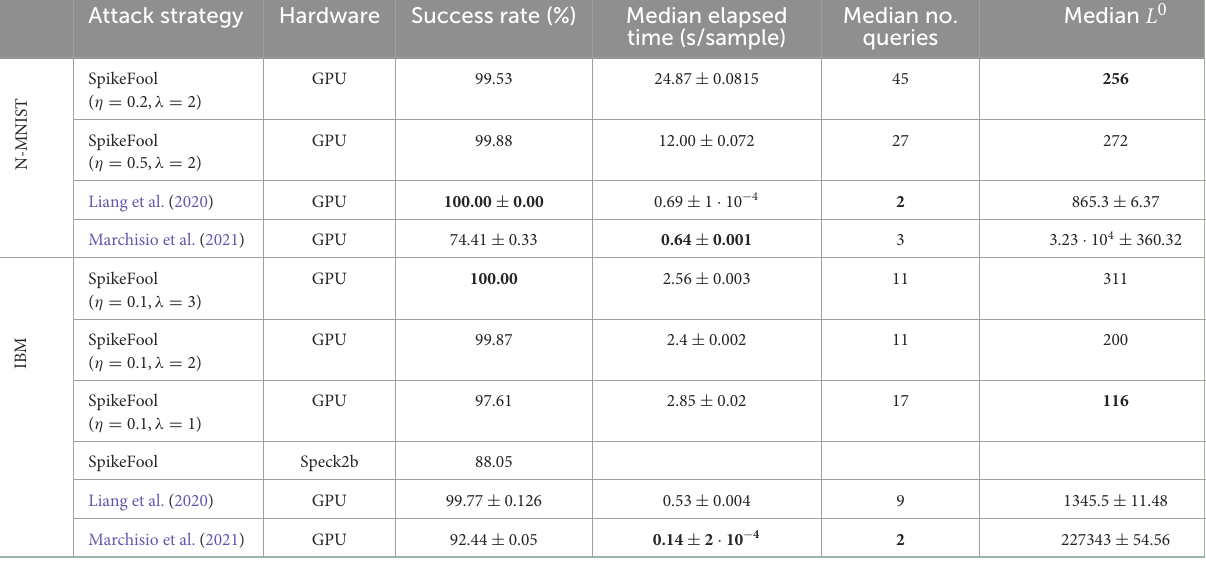
TABLE 1 Result comparison between SpikeFool and related